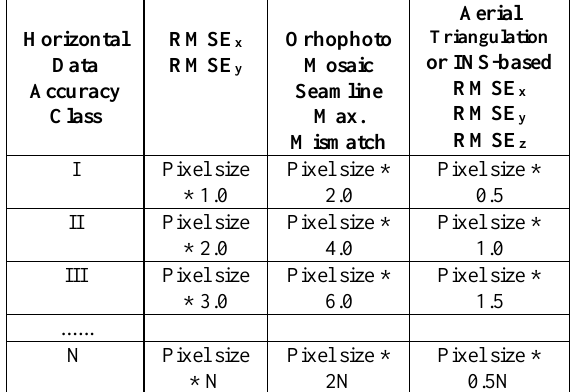
Table 3. Horizontal accuracy standards for orthophoto